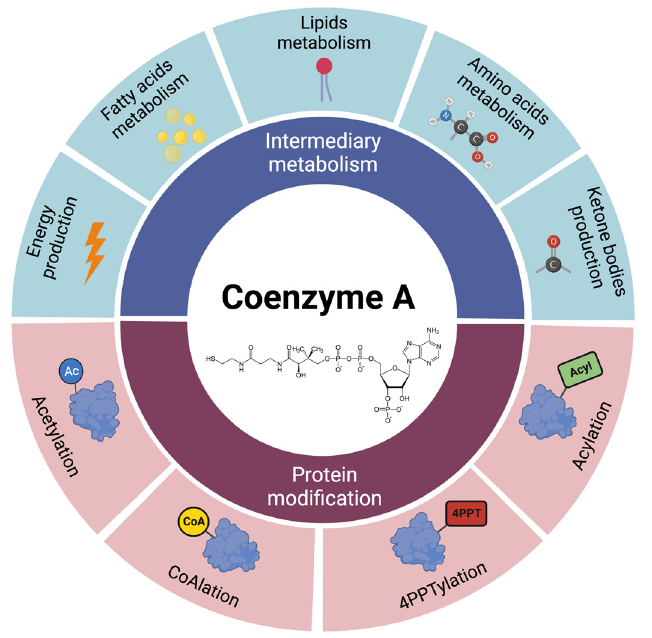
Figure 2. Coenzyme A cellular functions. CoA is implicated in diverse cellular activities, which can be divided into metabolic (blue) and protein modification (red) functions.